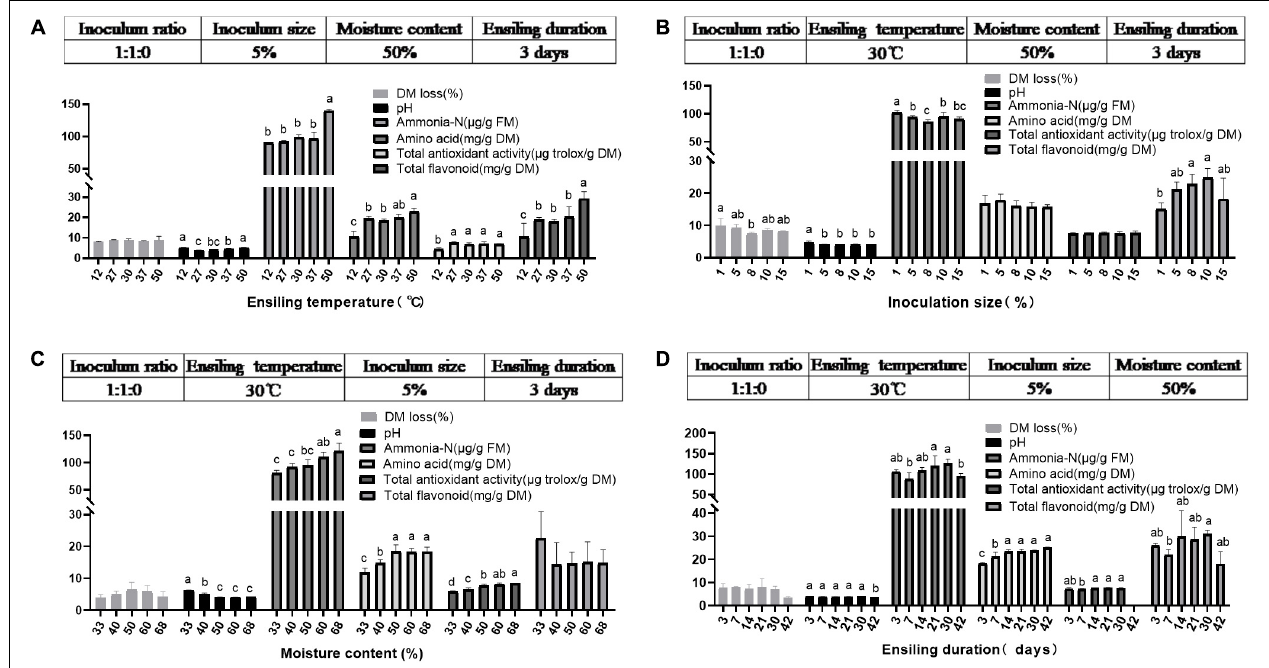
FIGURE 2 | Characteristics of ML silage under various ensiling temperatures (A) , various inoculum sizes (B) , various moisture levels (C) , and various ensiling duration (D) using the single-factor experimental method in trial 2 . Different letters in the same index among groups differed ( P <